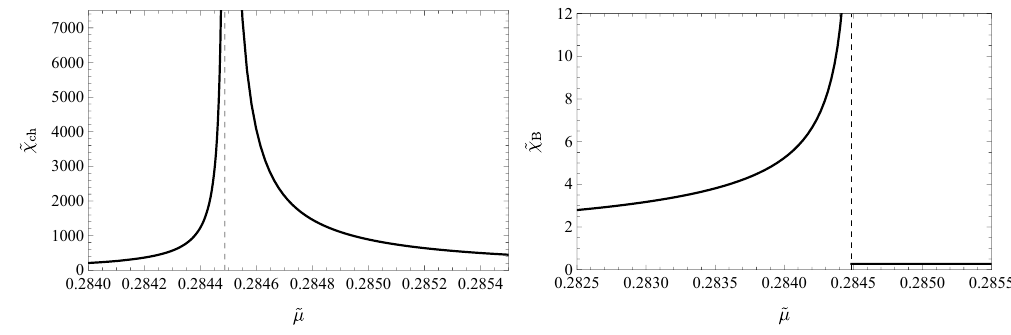
Figure 13 . The critical behaviors of the chiral susceptibility (left panel) and the baryon number susceptibility (right panel) with t = 0 fixed. The vertical dashed line denotes the critical value of the chemical potential ˜ µ = ˜ µ t , corresponding to g = 0 .